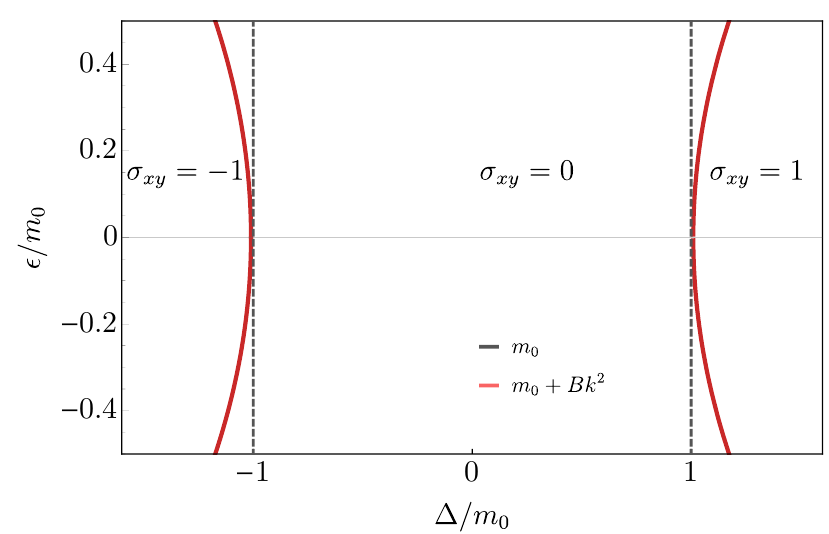
Figure 4: Phase diagram for the stationary system described by Eq. (3) in the presence of weak disorder. The dashed, gray lines denote the energy where the semiclassical value of σ equals ± 1 for m ( k ) = m and the bold red lines denote the critical x y 0 2 energies for a disordered system, [ Eq. (9) ] . The Hall conductivity indicated in each region refers to the Hall conductivity at the RG fixed point. B = 0.5 v 2 in the